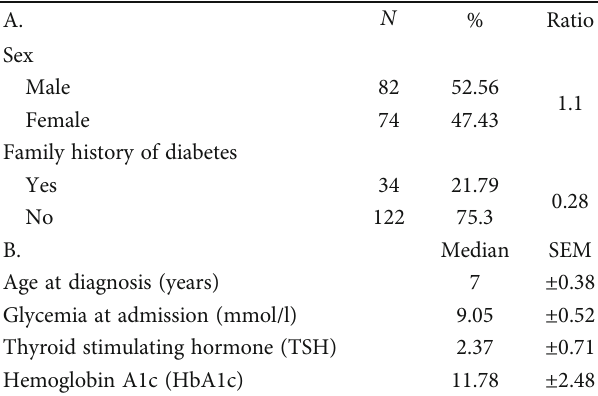
Table 1: Demographic and clinical features of T1D Tunisian children ’